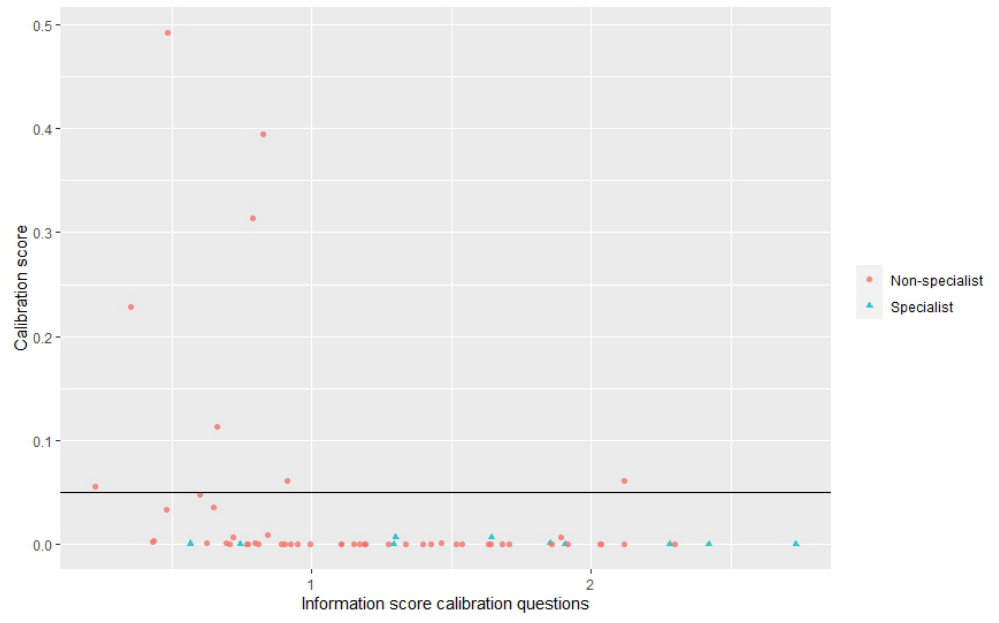
Figure A1. Comparisons of experts’ calibration and information scores for calibration questions per domain expertise.